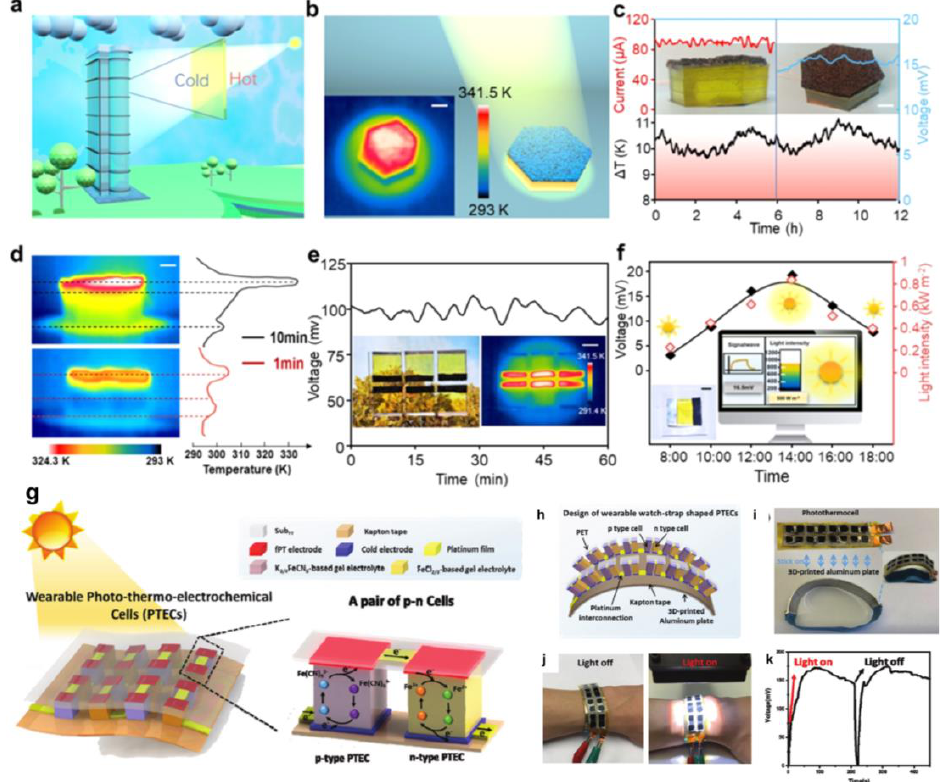
Figure 17. Demonstration of harnessing solar energy. ( a ) Panoramic view of a PG gel-based